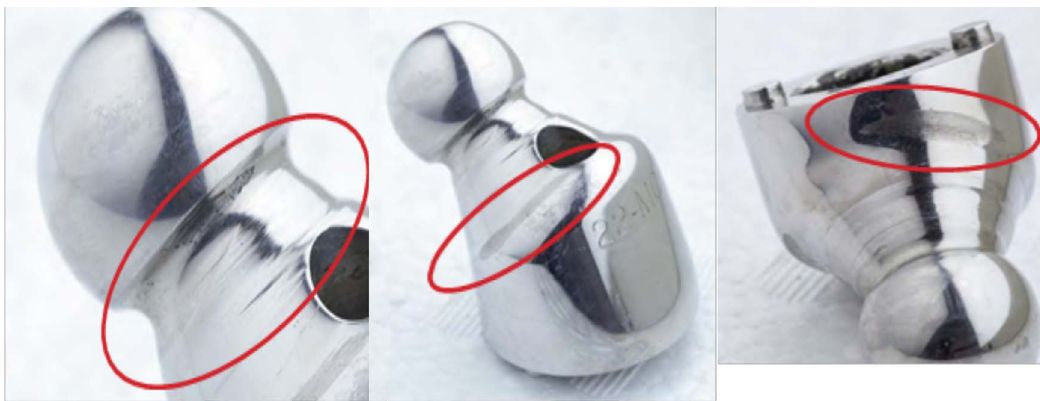
Figure 8. Deformations found on